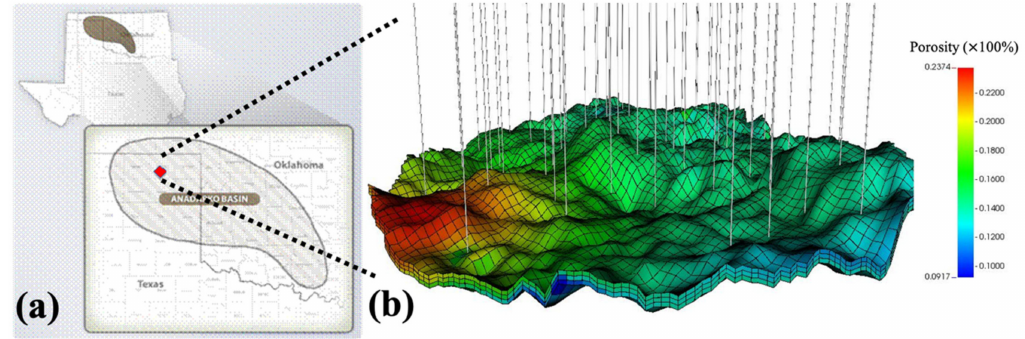
Figure 1. ( a ) Location of the Farnsworth Unit (FWU), and ( b ) a three-dimensional (3D) reservoir model of the Farnsworth